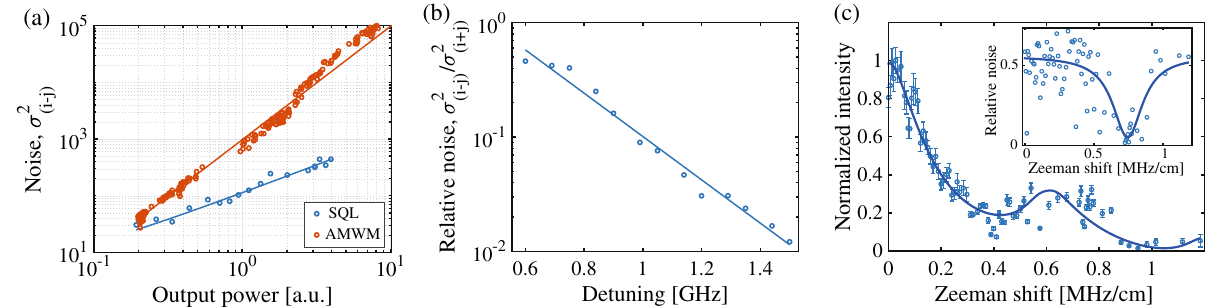
Figure 6. ( a ) Intensity-difference noise fitted with a quadratic model is shown as a function of the optical power for two modes of the four-wave mixing signal. The standard quantum limit (SQL) is measured using coherent laser beam pairs before the cell, and it is fitted with a linear line. ( b ) Relative noise as a function of 35 degrees with linear fitting. ( c ) Normalized intensity and relative noise (inset) of the pump detuning for δθ s = scattered ring signal as a function of the magnetic field gradient. The solid line in the main plot is the theory (see 200 γ , � 4 γ , γ 0 0.04 γ ), and the solid line in the the main text) using typical experimental values (e.g. � = = = inset is a Lorentzian curve as a guide to the